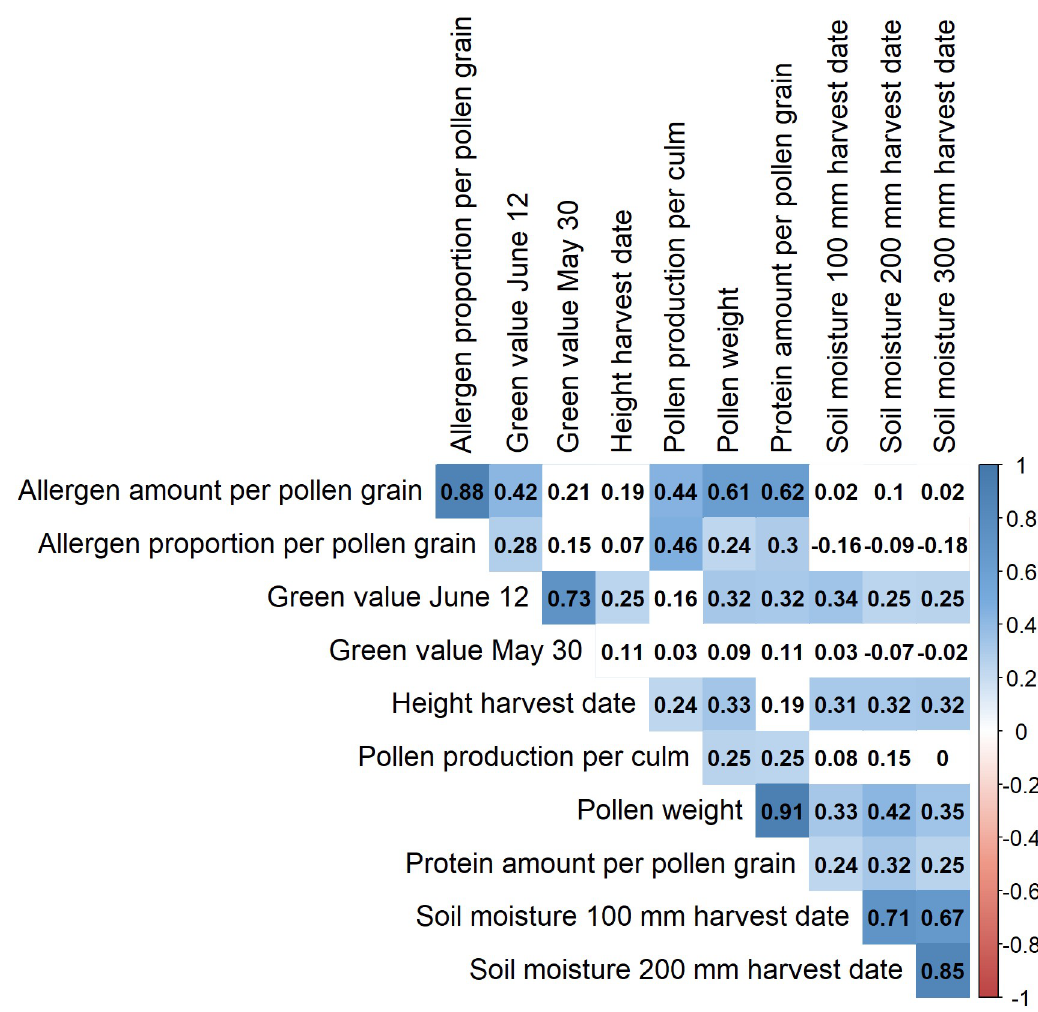
Fig 7. Spearman correlation including all treatments and the parameters allergen content (ng), allergen percentage (%), green value on May 30 and June 12, height at harvesting date (cm), pollen production per culm (mg), protein content (ng), pollen weight per grain (ng), and soil moisture in 10 cm, 20 cm and 30 cm depth at the harvest date; (level of significance 0.05, significant positive correlations indicated in